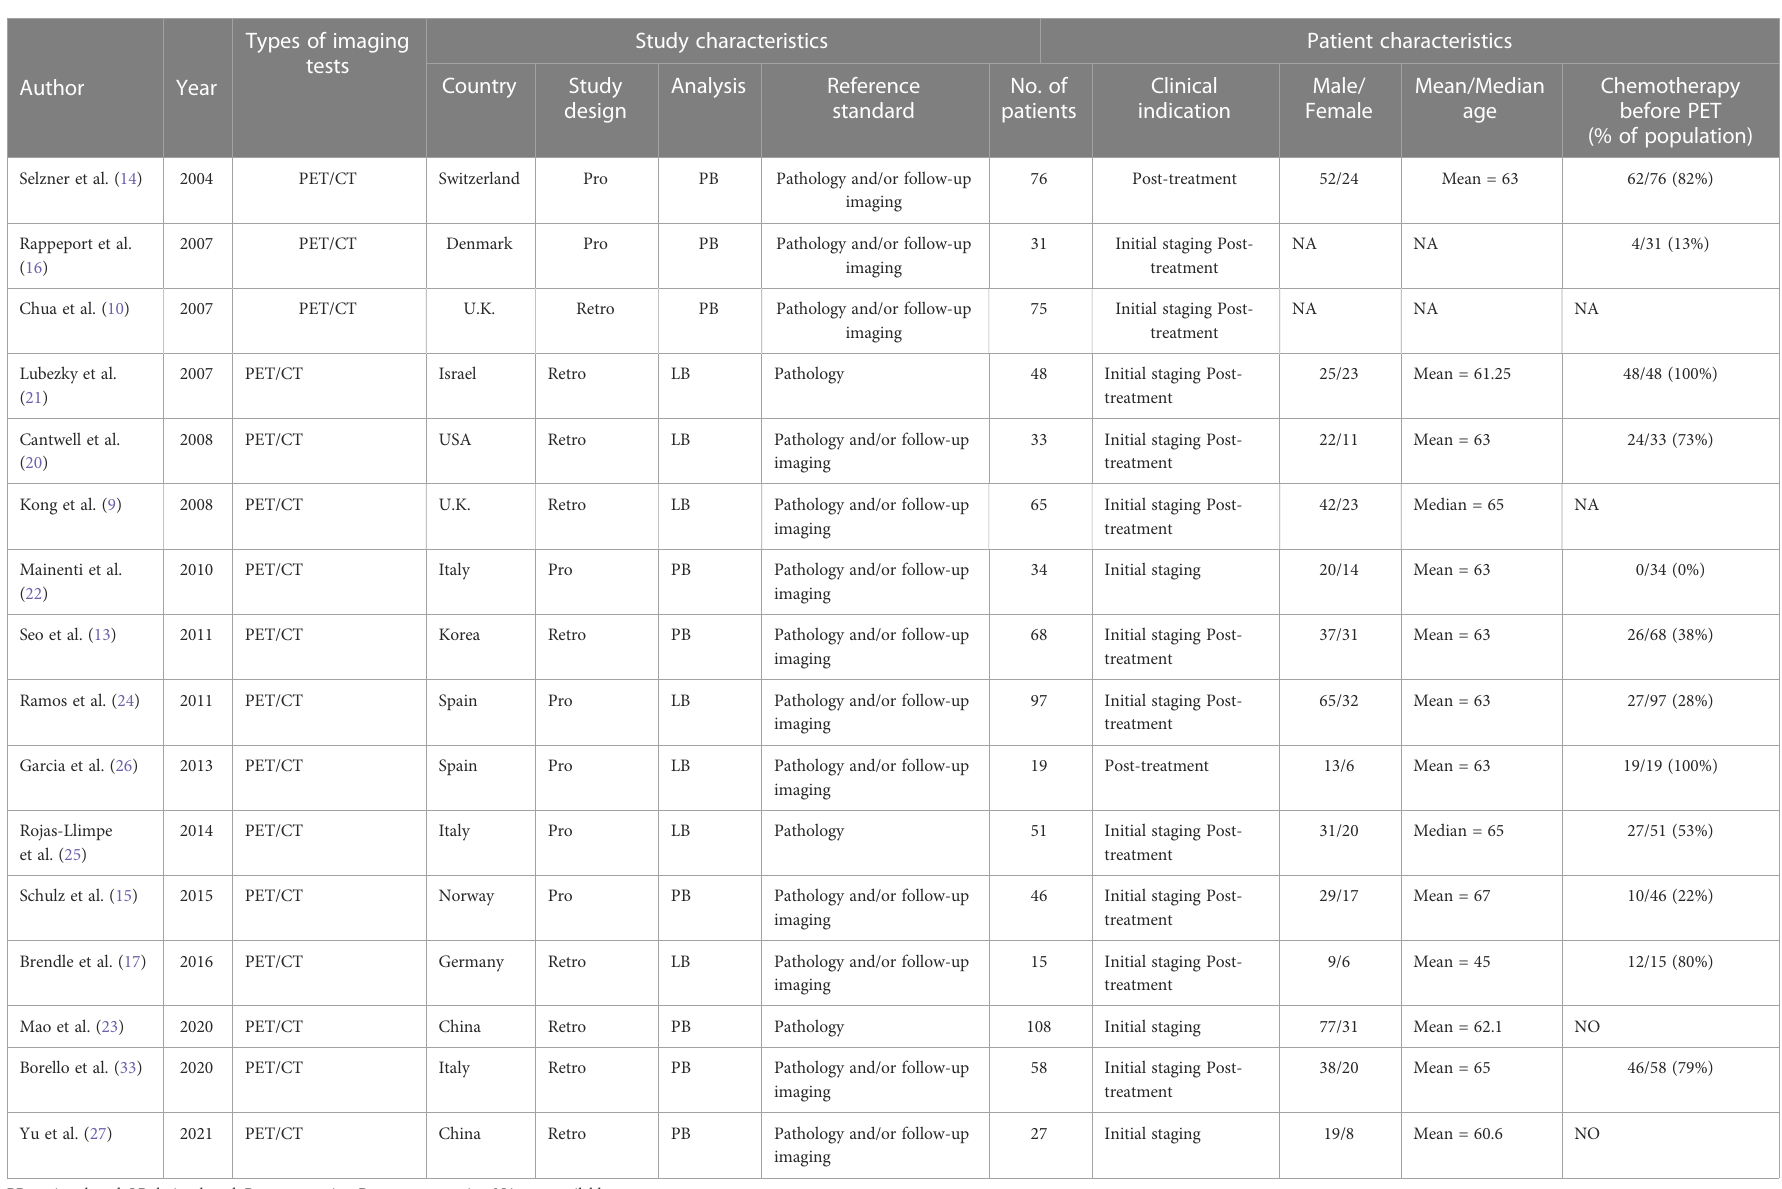
TABLE 1 Characteristics of the studies and patients for [18F]FDG